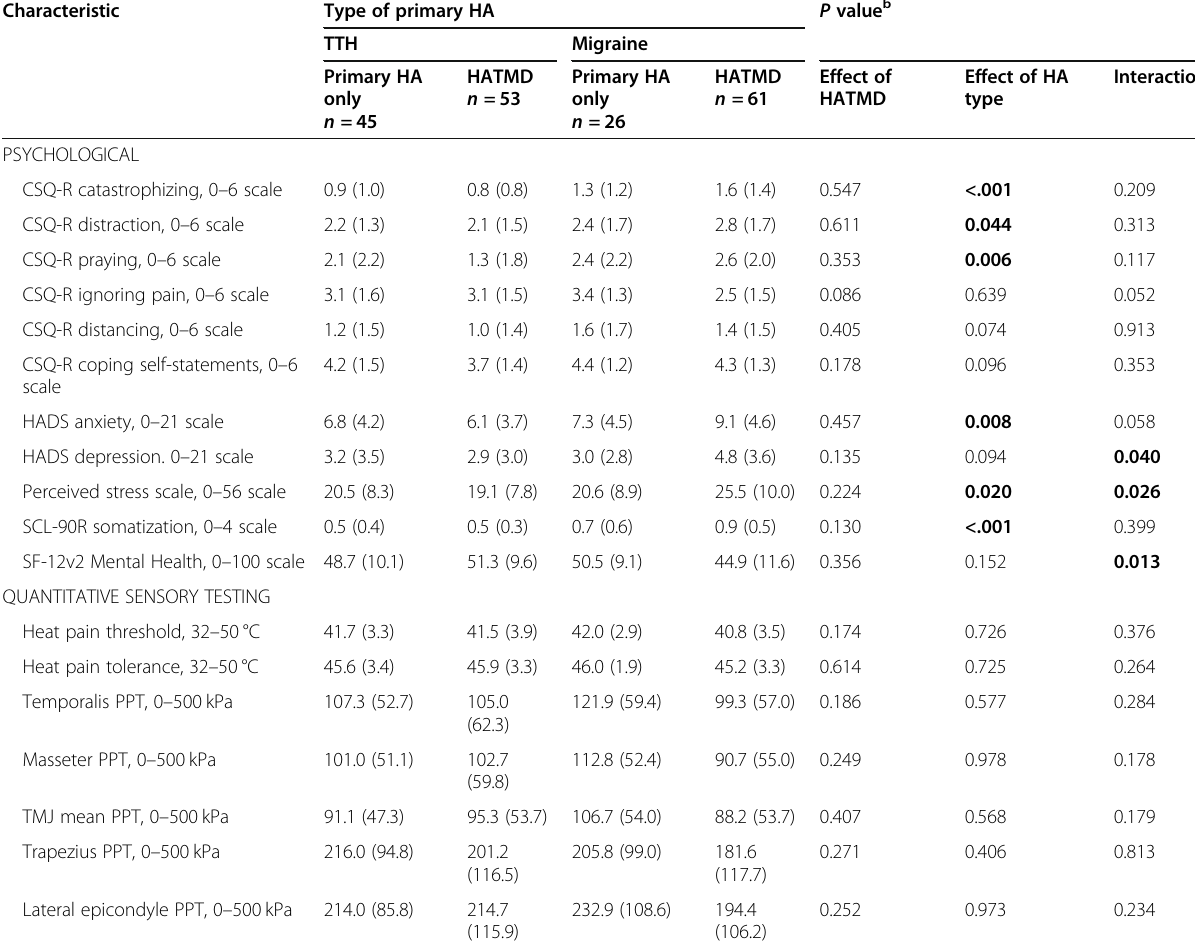
Table 2 Psychological and QST characteristics in four groups classified according to primary headache and HATMD a